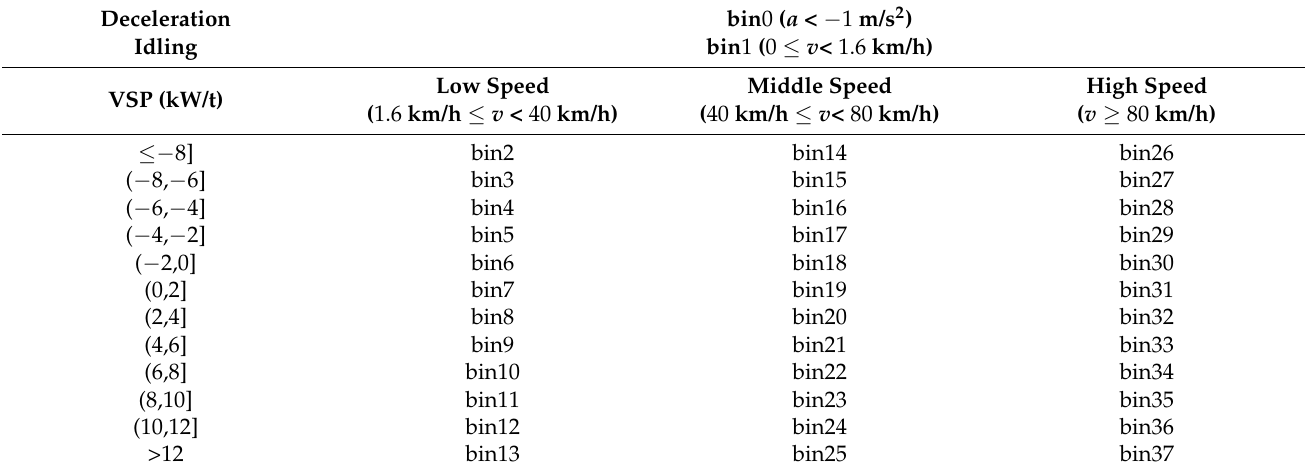
Table 1. The division standard of 38 VSP-bins according to the vehicle operation state and the calculated values of VSP.